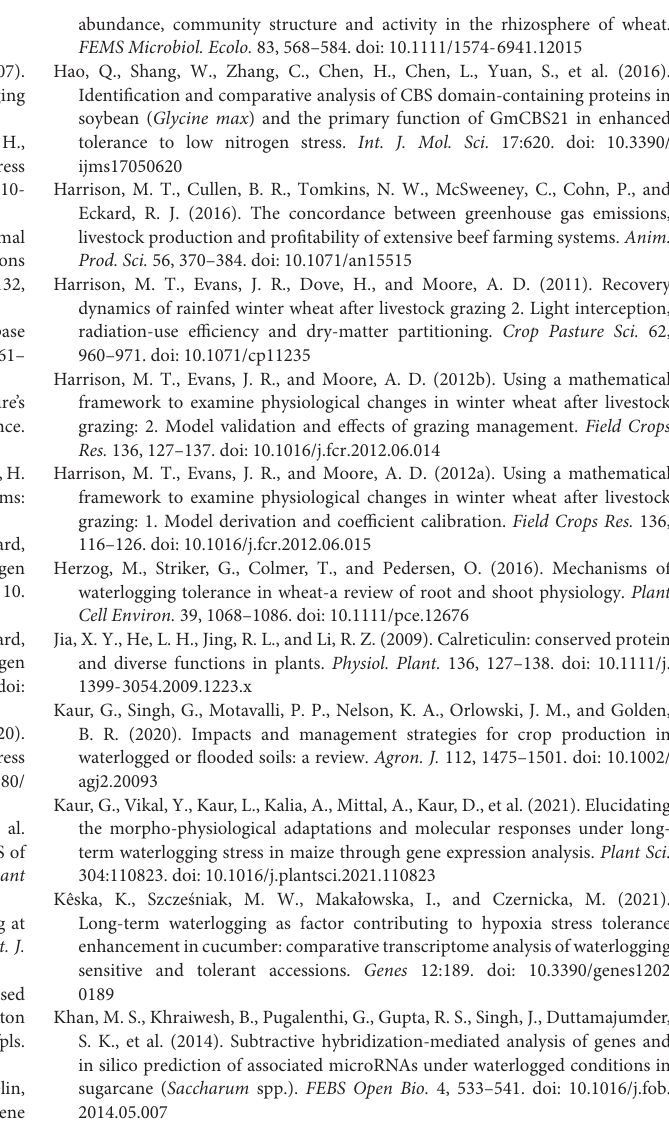
Supplementary Figure 1 | GO annotation of differentially expressed proteins between WL and CK in XM 55. Supplementary Figure 2 | GO annotation of differentially expressed proteins between WL and CK in YM 158. Supplementary Figure 3 | SDS-PAGE analysis for the